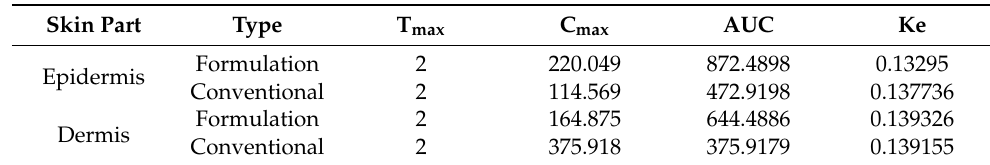
Table 2. Dermatokinetic study chart.